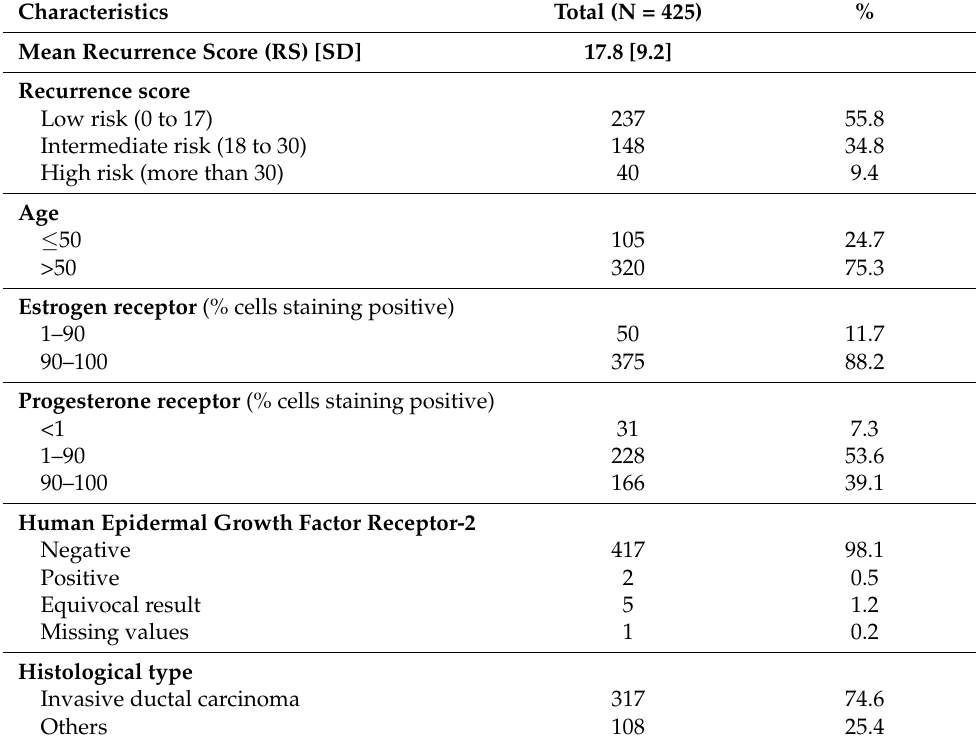
Table 1. Characteristics of the study